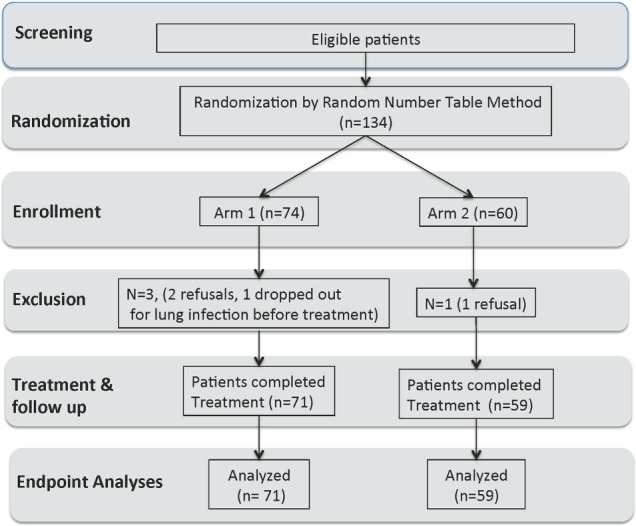
Consort diagram of patient randomization and treatments.